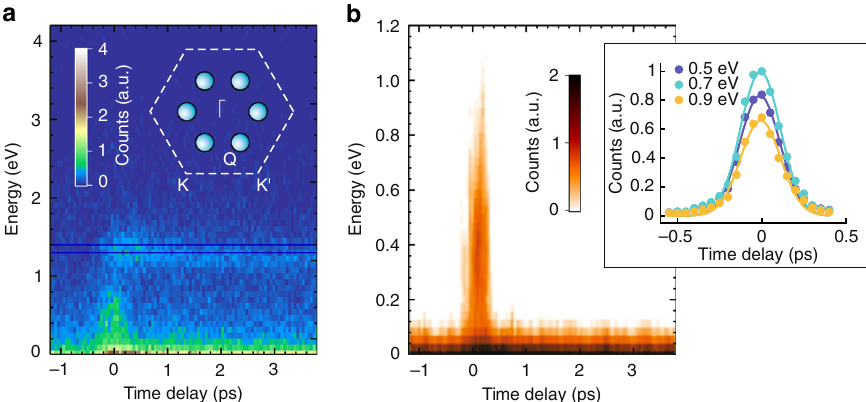
Fig. 7 Time-resolved ARPES results in WSe 2 . a Population lifetime of the excited electrons in the Q valleys. Inset: Brillouin zone of WSe 2 showing the six inequivalent Q valleys located in between Γ and K points. b Photon-dressed states emerging within the bandgap, taken at higher energy-resolution and narrower energy window. Inset: Photoemission counts as a function of time delay, taken at three different energy cuts